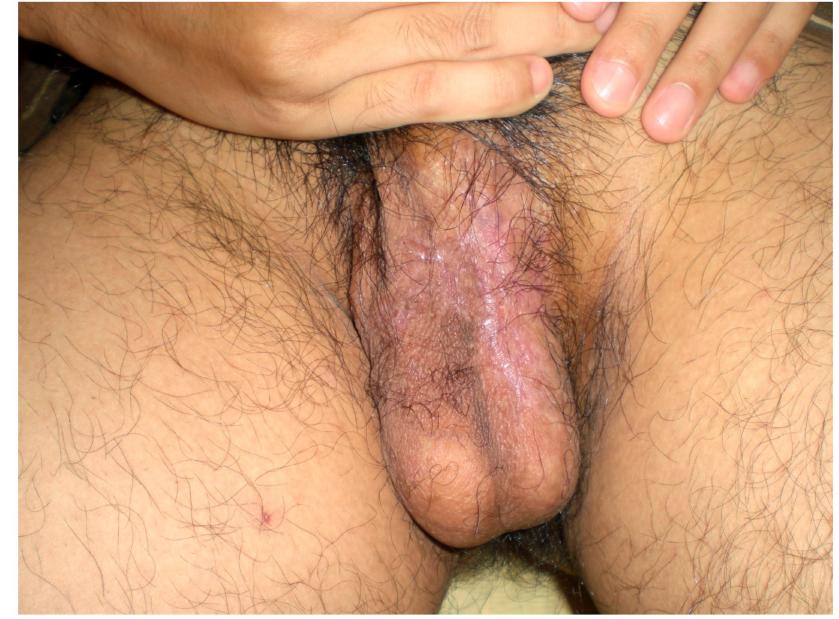
Figure 4. The scrotal ulcer of pyoderma gangrenosum (PG) was totally healed after one